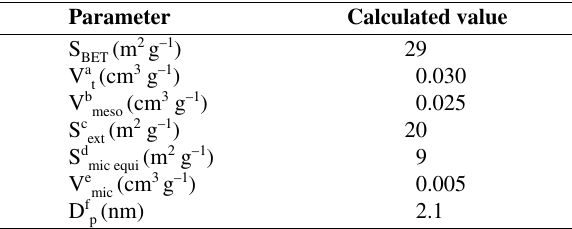
Table 2: Textural parameters of FS natural clay Parameter Calculated